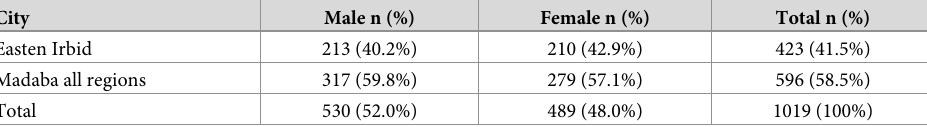
Table 1. Source of 1019 nasopharyngeal samples according to the gender in the winter seasons of 2017–2018 and